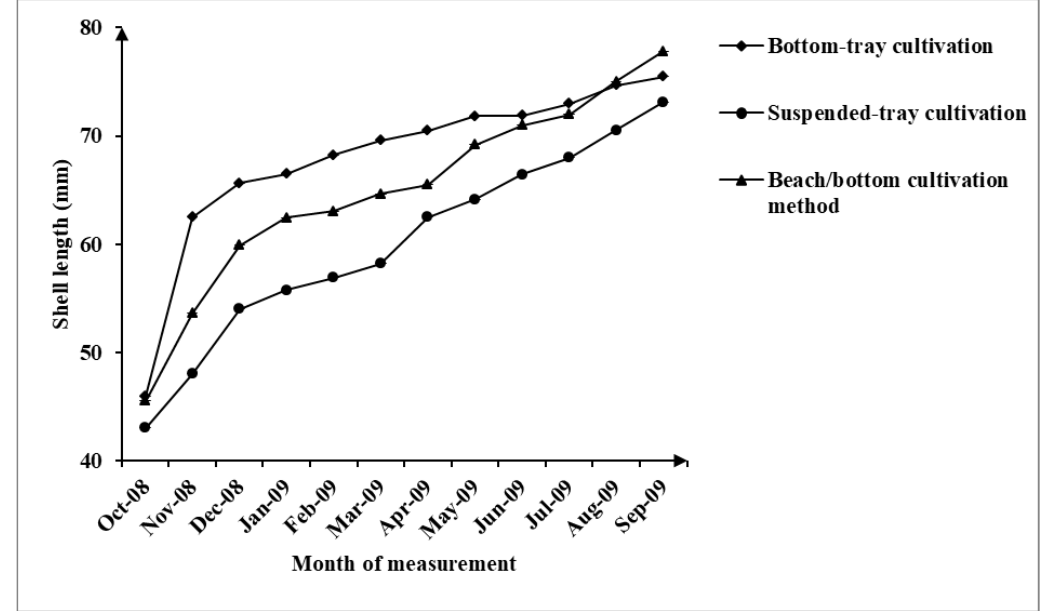
Figure 1. Experimet was conducted from October 2008 to September 2009, this results showed monthly average of shell length (SL) of snout otter clams in bottom-tray cultivation, suspended-tray cultivation, and beach/bottom cultivation methods. The values represented the average of three replicates ± SD ( p < 0.05 ).